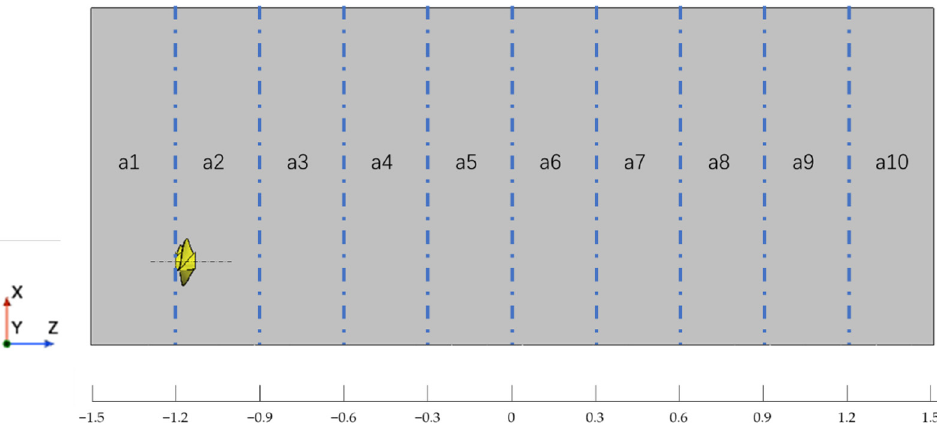
Figure 13. Regions of the flow field divided along the axial direction.